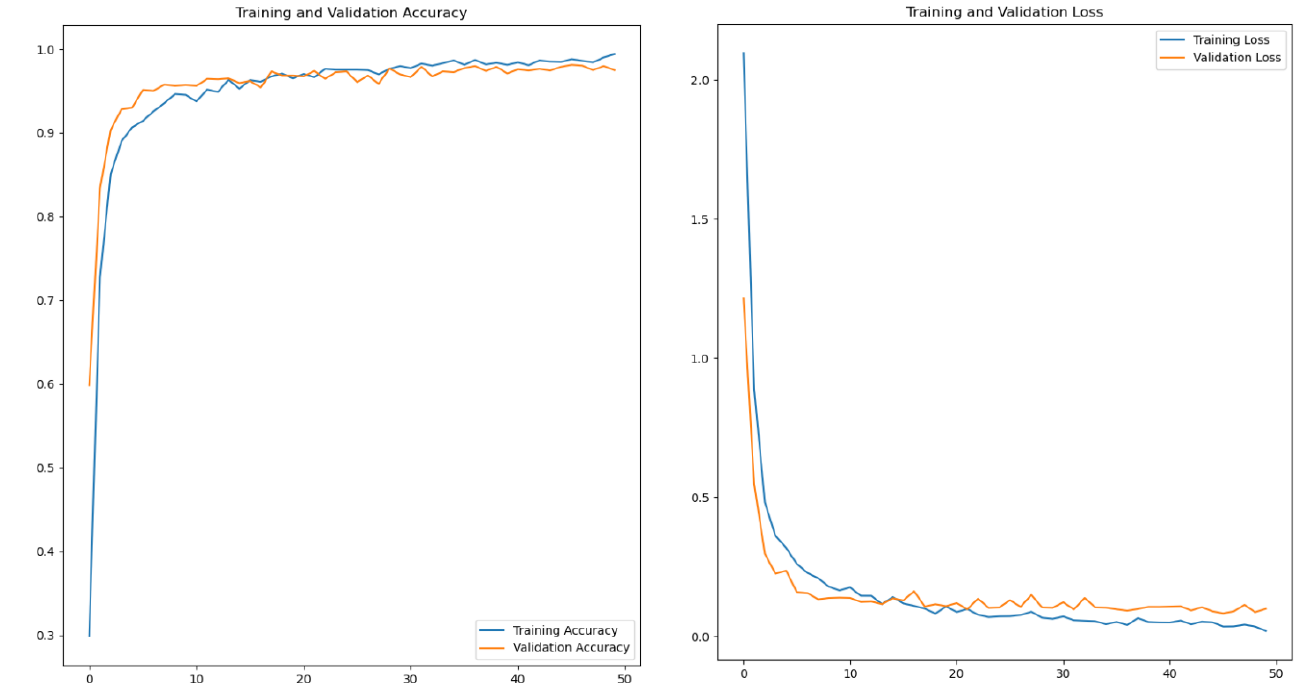
Figure 20. The accuracy ( left ) and loss ( right ) on training and validation.